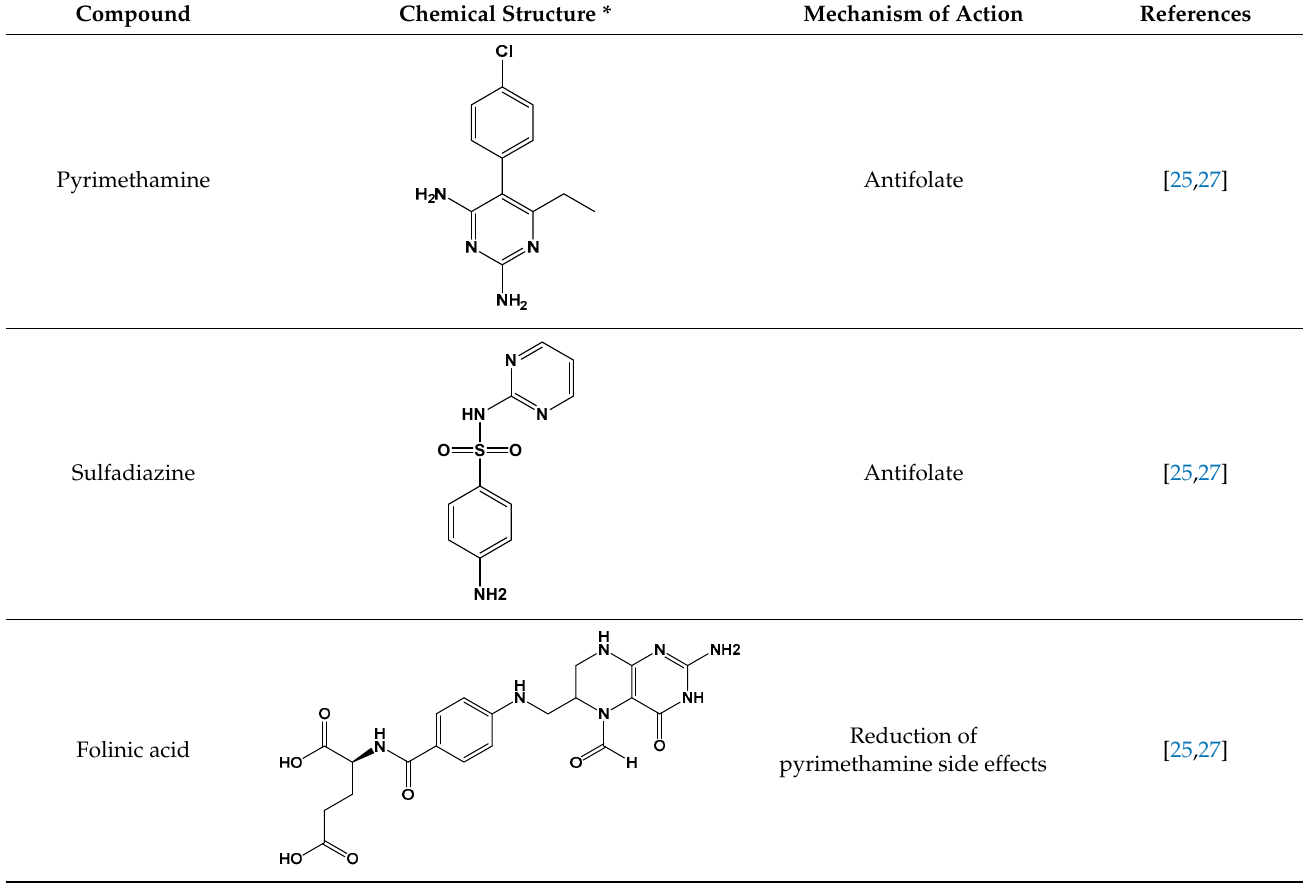
Table 1. Current drugs used for toxoplasmosis treatment.